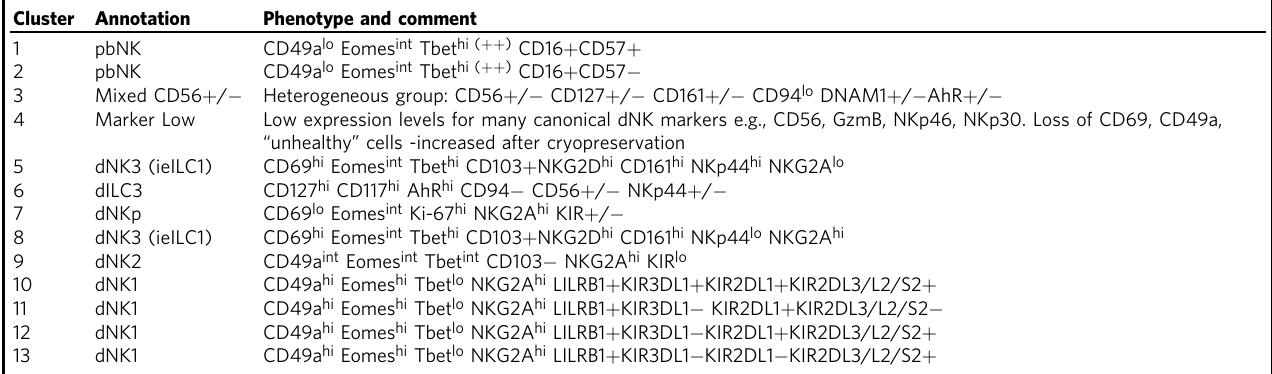
Table 1 Identity of Lin − clusters in Fig. 2, based on